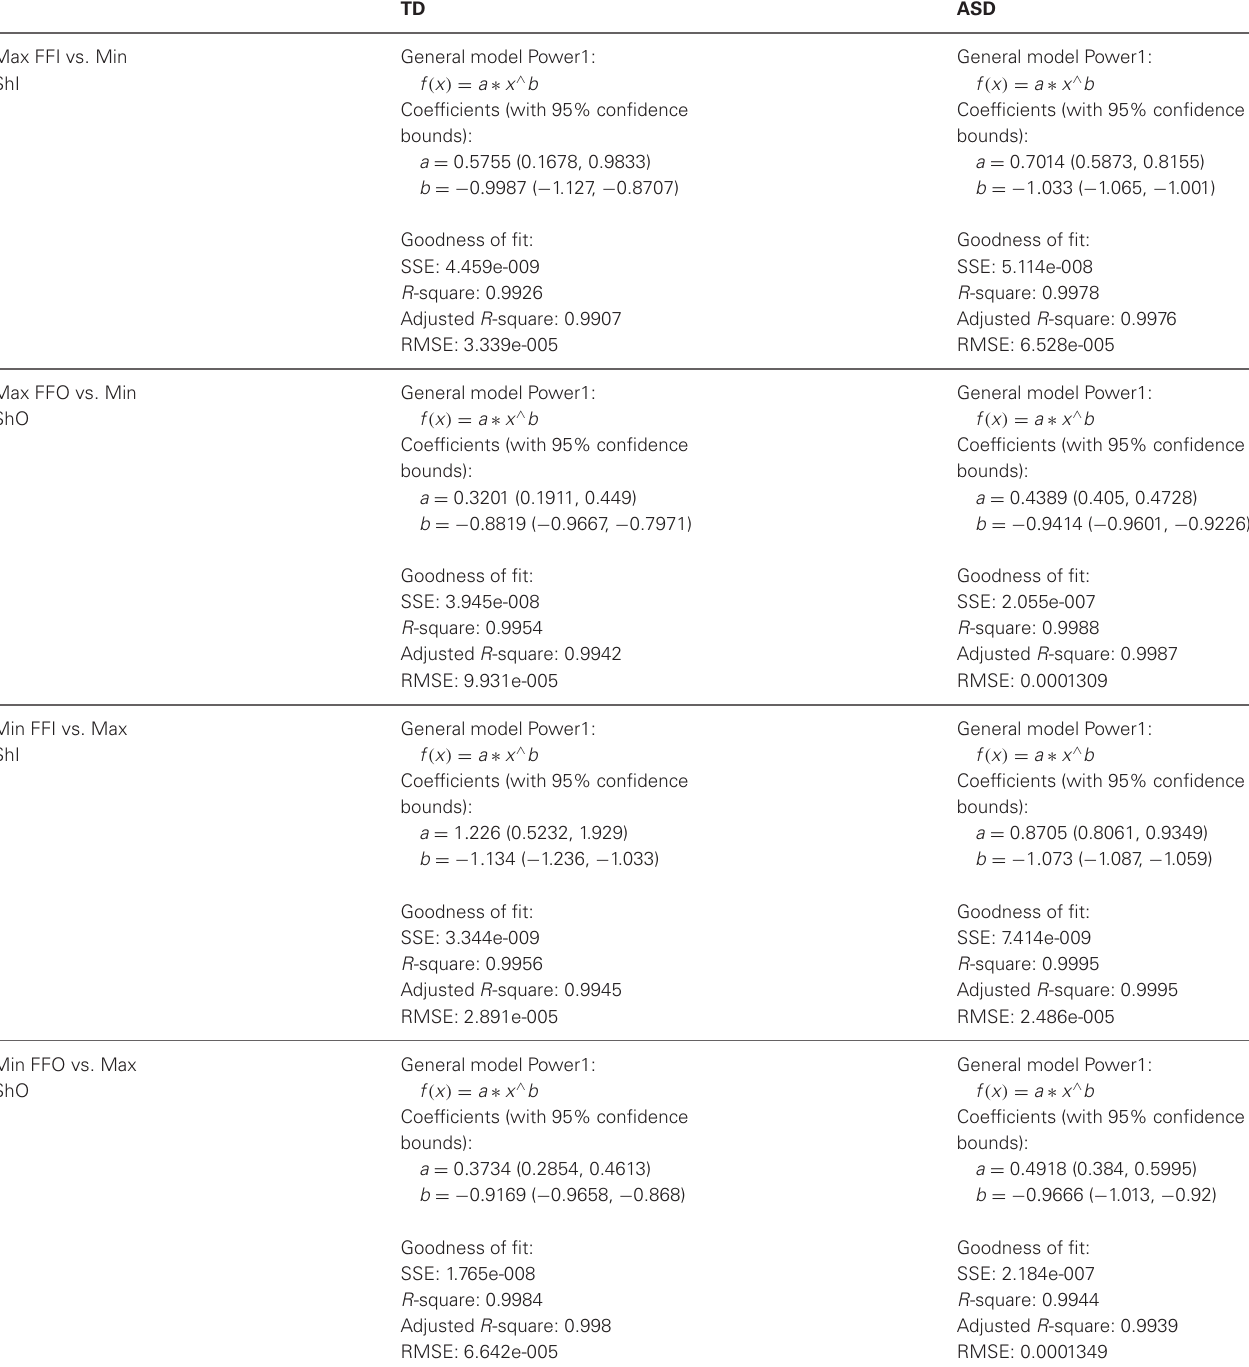
Table A4 | Goodness of fit parameters of the power fits in Figure 11 for the worst (lowest reliability and predictability) and best (highest reliability and predictability) of the micro-movements’ statistics as they change in tandem with the media states statistics IN and out of the vRoI for both the TD and ASD